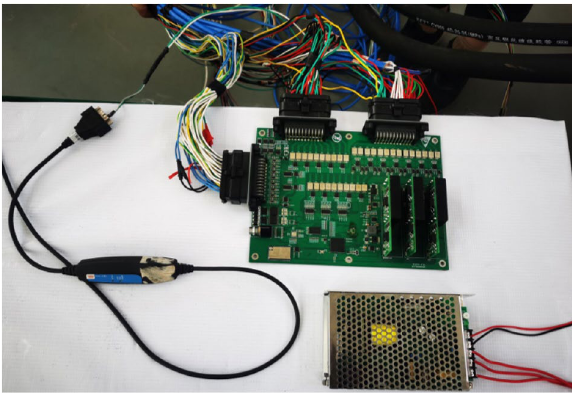
Figure 17. Controller of the advanced hydraulic support group.